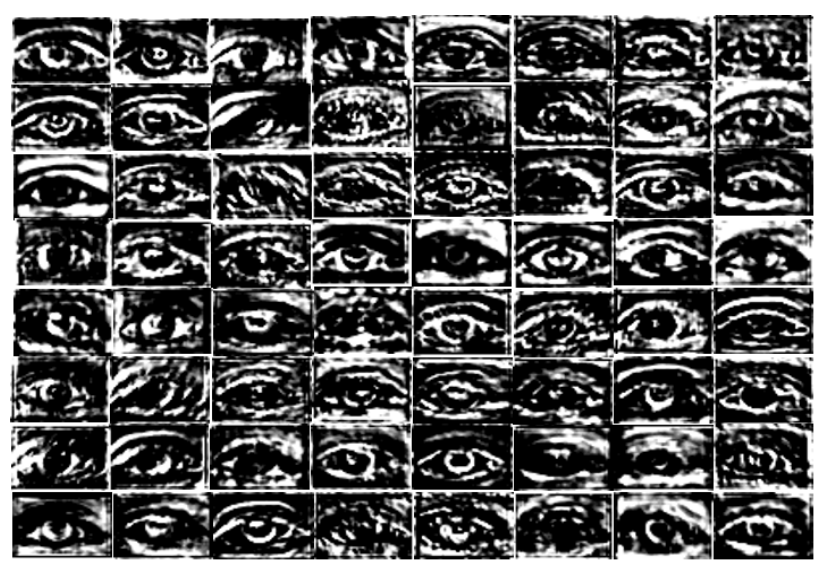
Figure 19. SegNet-Basic last 64 channel (the 449th to 512th channels) features before the 4th max-pooling (Pool-4).